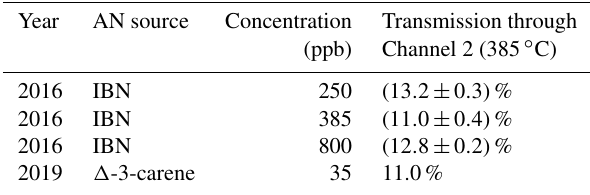
surements and updating correction factors accordingly.